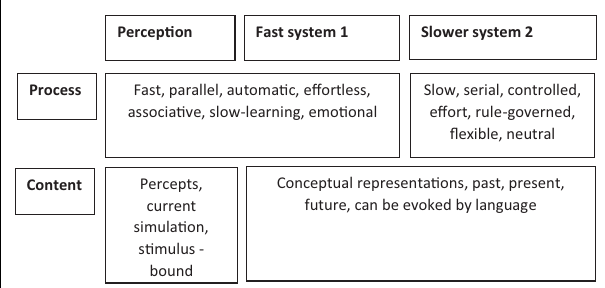
open access, permission grated.